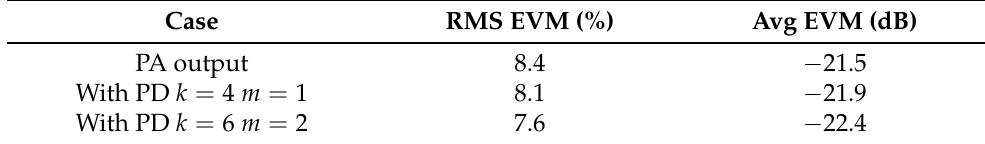
Table 3. Predistorter effectiveness for the QPSK 18–MHz signal through a virtual PA (Saleh